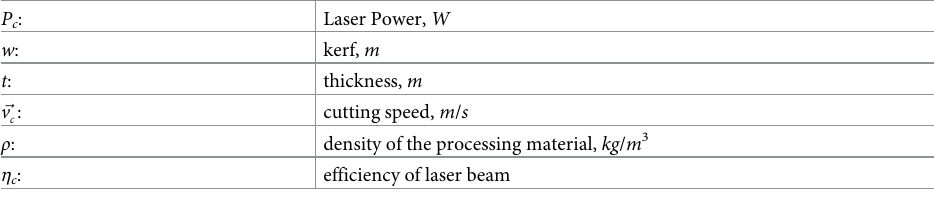
Table 1. Component terms of equation for laser